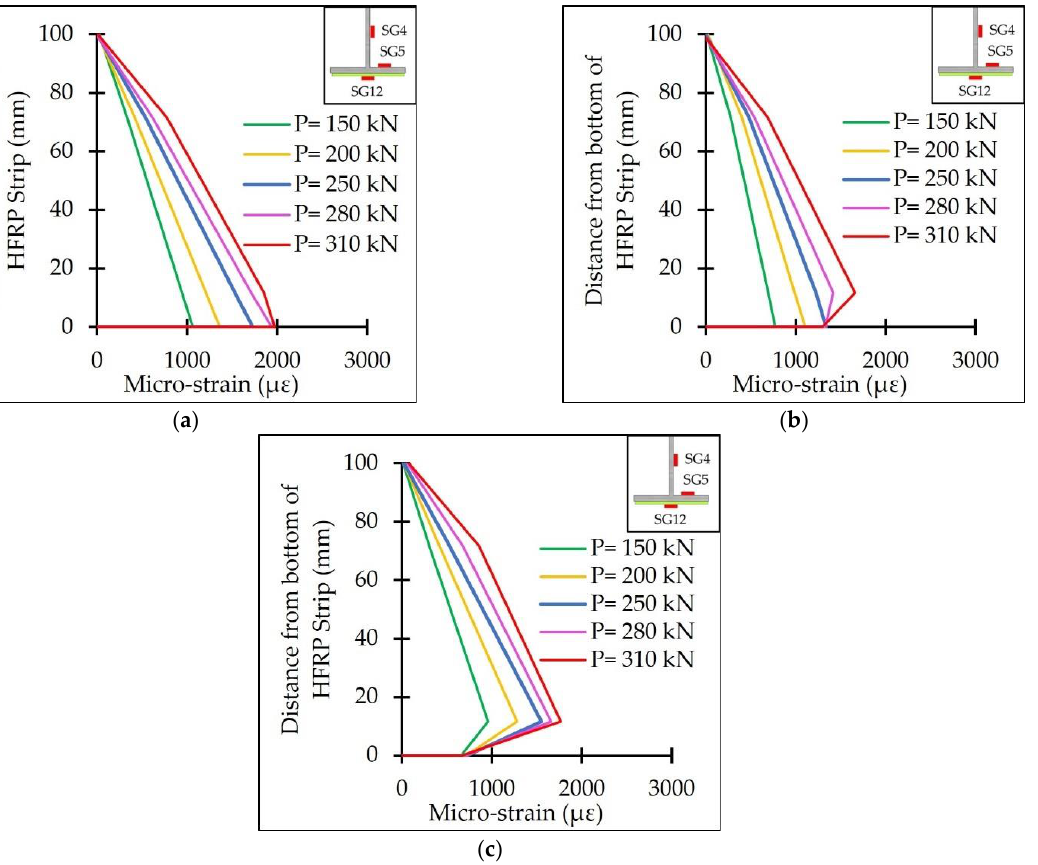
Figure 21. Distribution of the tensile strains at the mid-segment of: ( a ) 1620-S-100; ( b ) 1170-S-100; ( c ) 810-S-100.